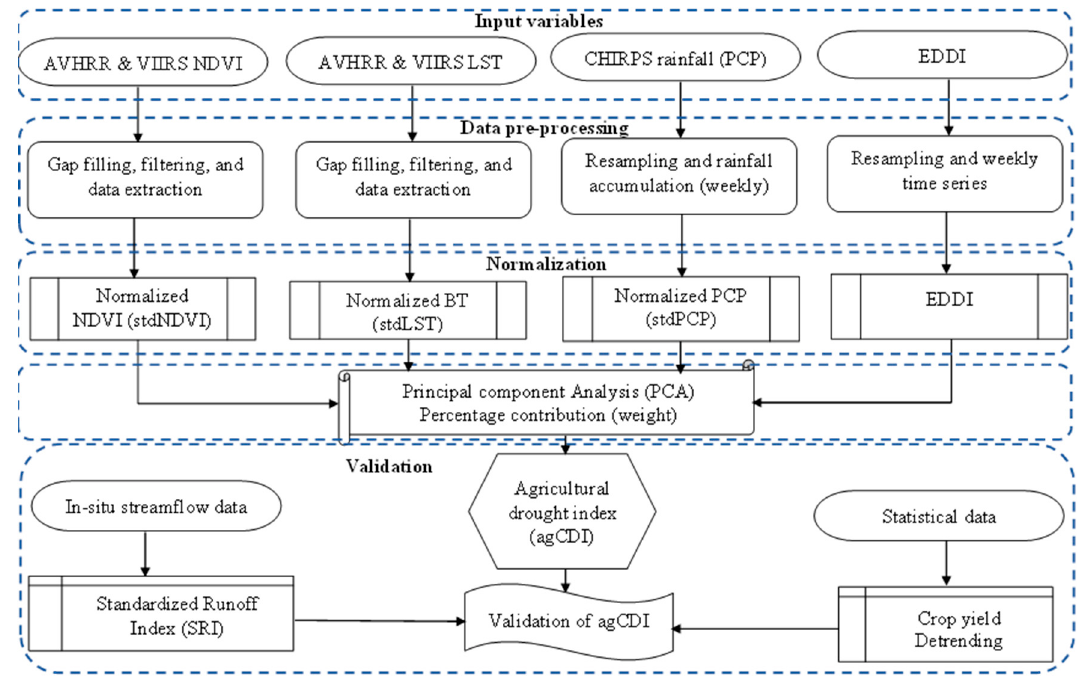
Figure 3. Summary of the method used in this study.